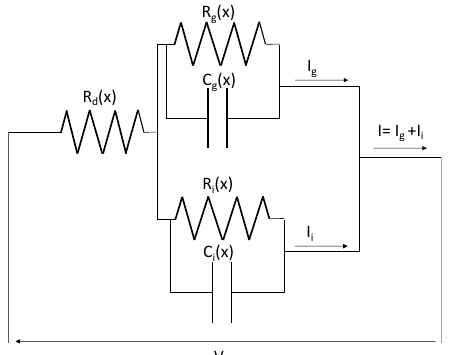
Figure 5. Surface discharge at the surface of a coated electrode in SF6 with 1 bar under LI+ according to Reference [18].